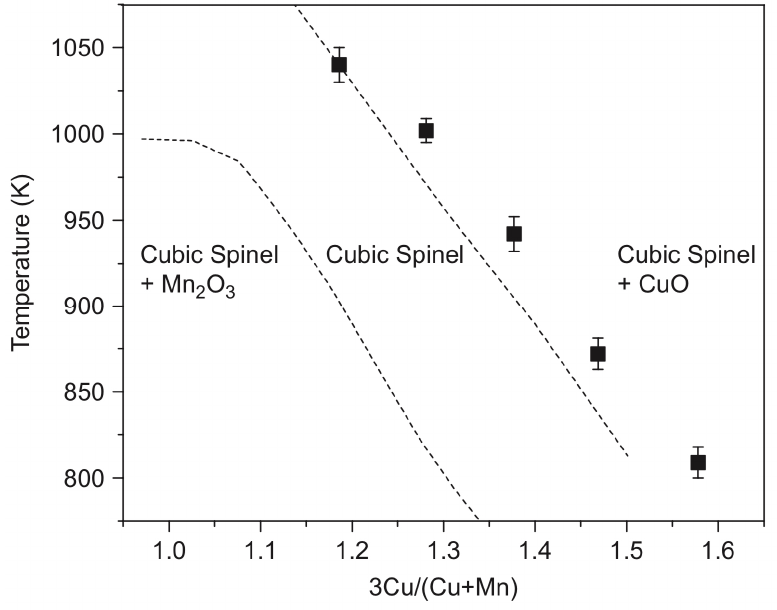
Figure 2. Stability region of the cubic spinels in the Cu–Mn–O system in air (reproduced from [9]).